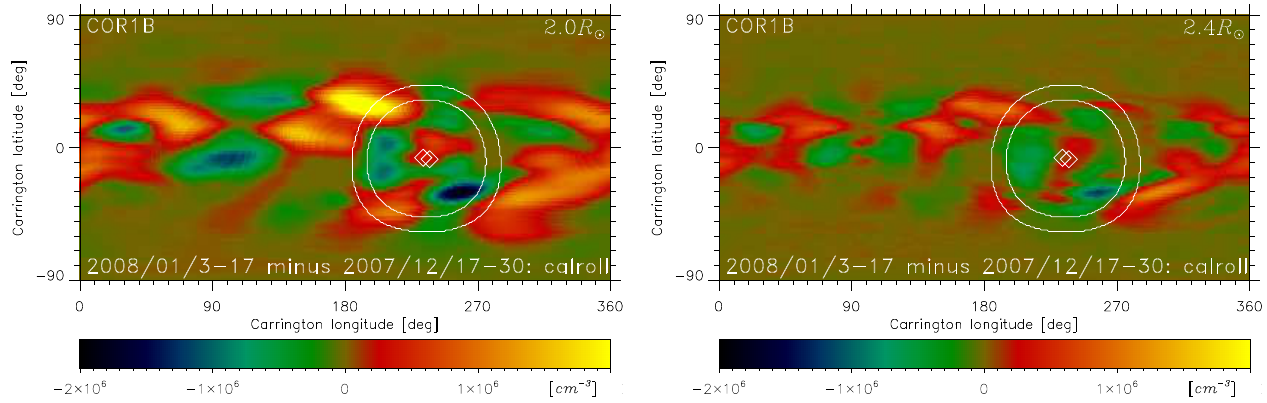
Fig. 7. Difference in reconstructed electron density for the periods after and before the CMEs of 31 December 2007 (CME2a) and 2 January 2008 (CME2b). The spherical cross-sections are shown at heliocentric distances 2 . 0 and 2 . 4 R ⊙ (the distances are shown in the right upper corners).